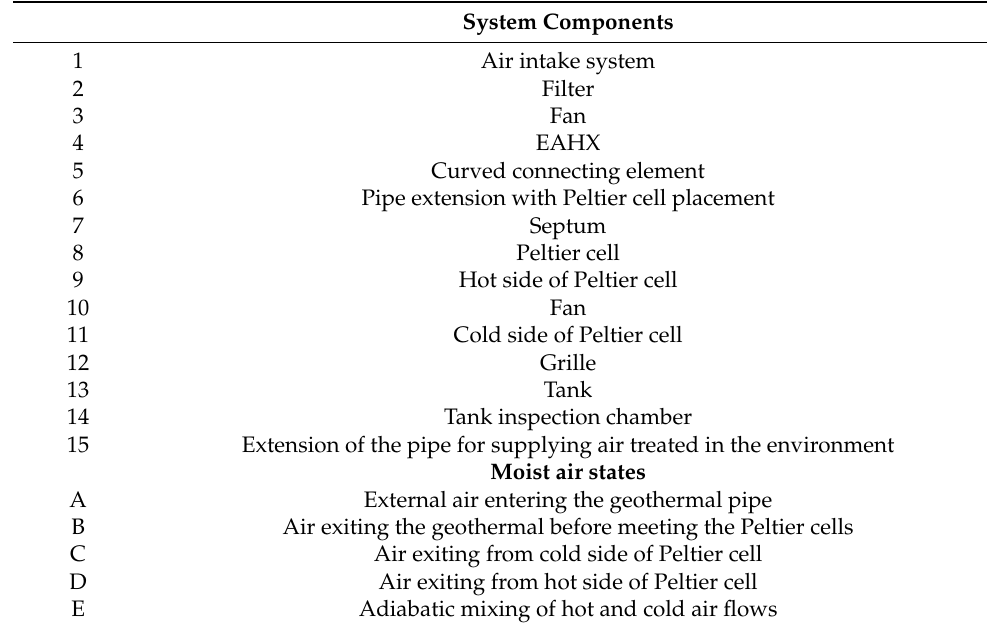
Figure 4. The entire system: open grille ( a ) and closed grille ( b ). Table 1. Labeling used for the description of the components of the system and moist air conditions in Figures 1–4.